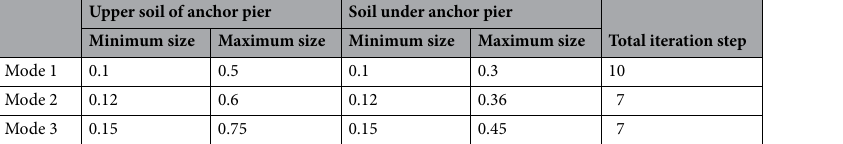
Table 2. Mesh size of three working